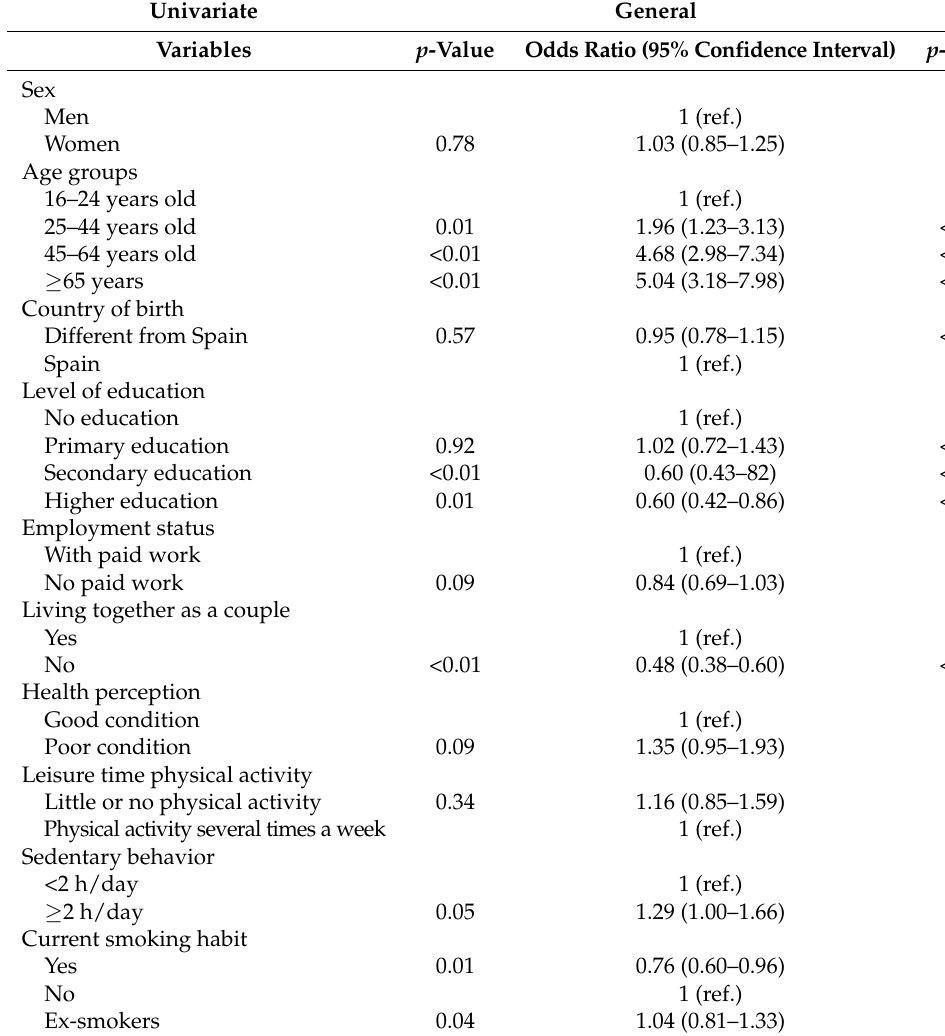
Table 4. Univariate analysis of risk factors related to high adherence to the Mediterranean diet in the adult population of southeastern Spain. Univariate General Men